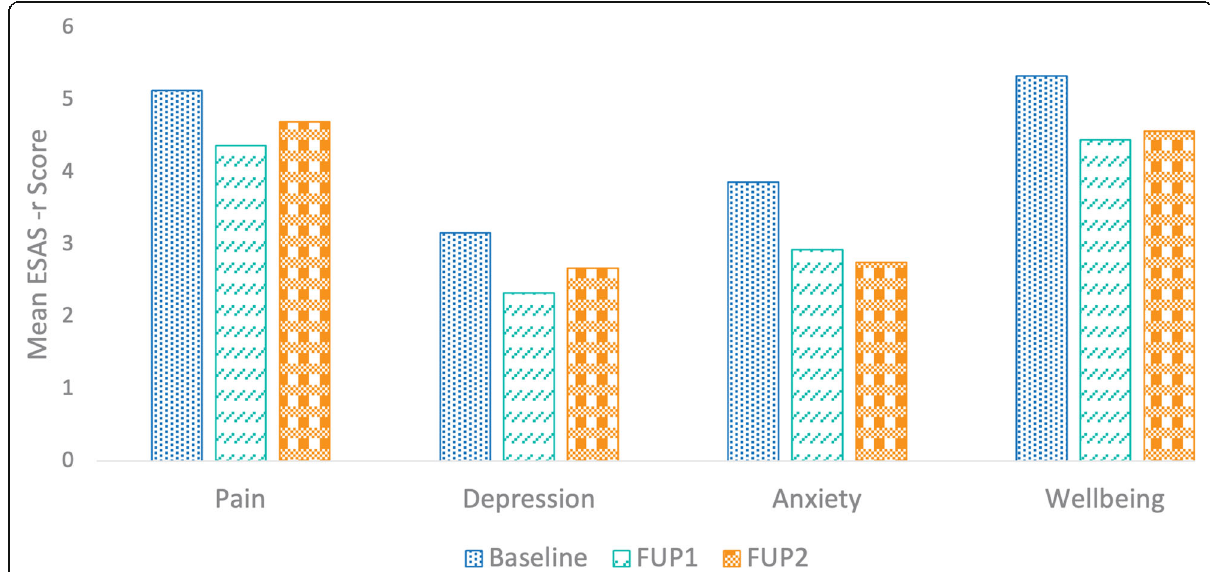
Fig. 1 CBD-rich treatment effectiveness on pain, anxiety, depression symptoms, and on overall wellbeing in 279 patients. FUP1, follow-up visit at 3 month; FUP2, follow-up visit at 6 month. Mixed ANOVAs revealed a significant effect of visit on symptom reduction between baseline and FUP1 but not between FUP1 and